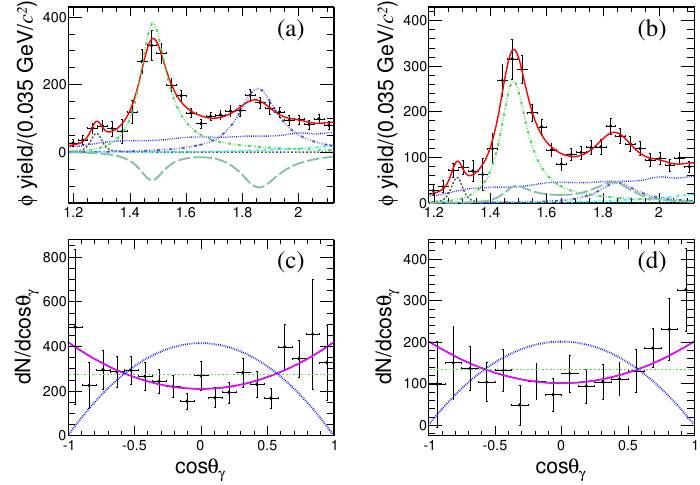
Figure 1. Fits to the M γφ distributions for the case of (a) constructive and (b) destructive interfer- ence. Fits to the cos θ γ distributions for invariant mass for (c) in [1.4,1.6] GeV/ c 2 region and (d) in [1 . 75 , 1 . 9] GeV / c 2